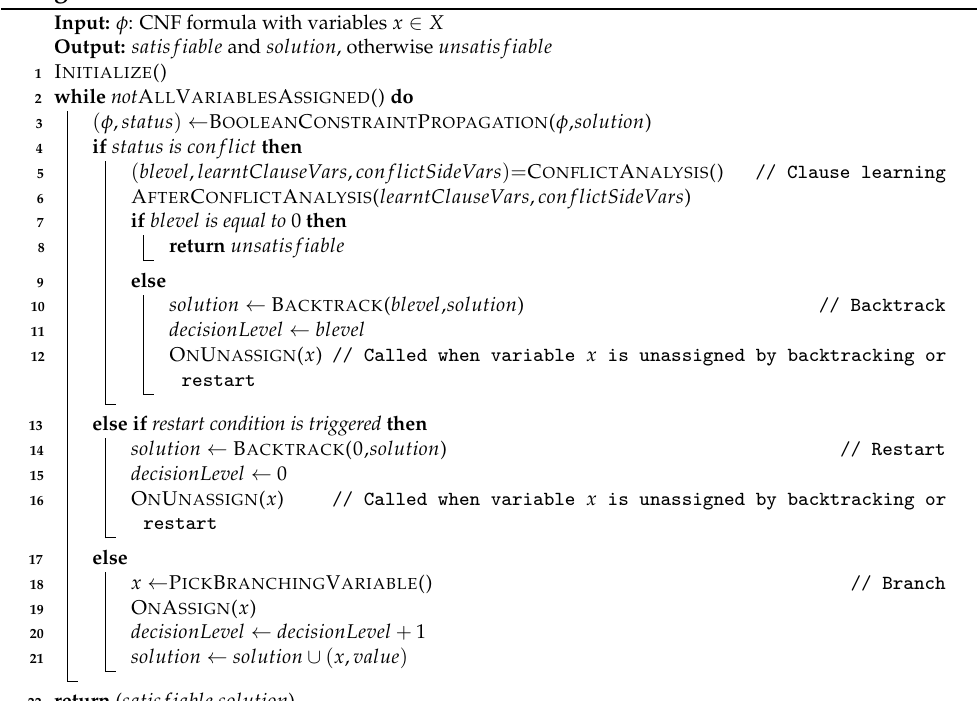
Algorithm A1: CDCL